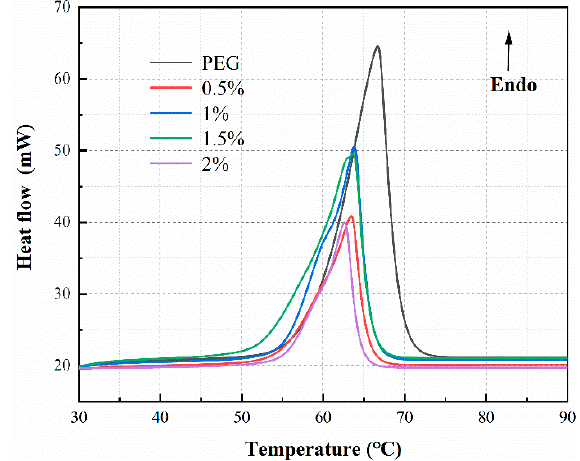
Figure 4. Melting differential scanning calorimeter (DSC) curves of the pure PEG and PEG/GNPs composites with the different contents of GNPs.